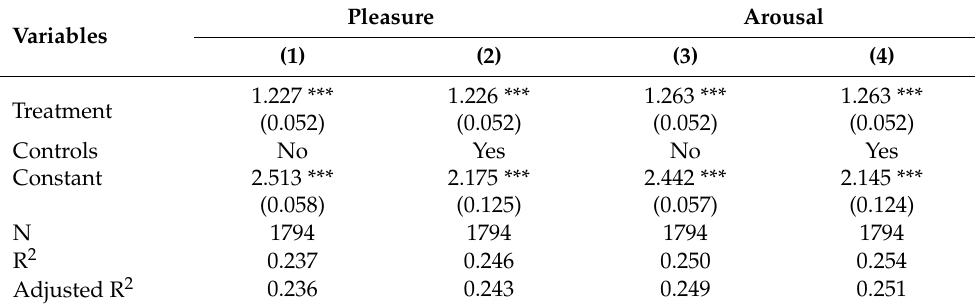
Table A7. The effect of commercial pedestrian streets on tourists’ momentary emotional experience.